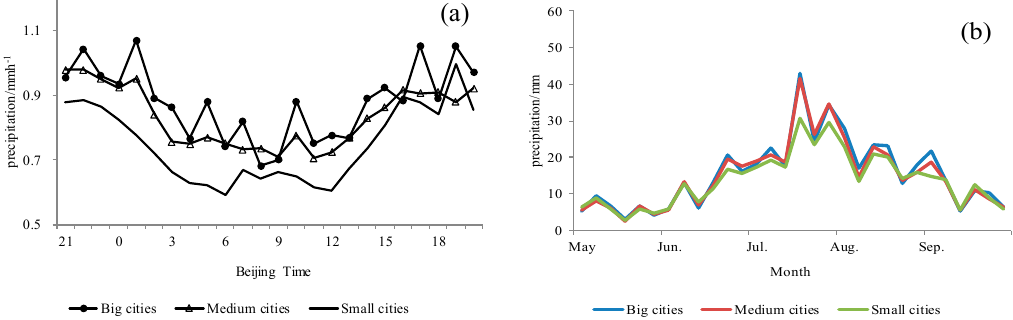
Figure 12. The diurnal precipitation variations (hourly mean precipitation) ( a ) and intra-seasonal variations (pentad mean precipitation); ( b ) for di ff erent categories of cities, 2007–2017. Overall, the annual total precipitation during the 11 years is 49.8 mm or 12% higher at the large city stations than that at the small city stations, and 33.8 mm or 8% higher at the medium-sized city stations than that at the small city stations (Table 1). The city stations are located at approximately similar elevations, with the large city station slightly lower than the medium-sized city stations, and 300 m lower than the small city stations (Table 1). Therefore, the possible e ff ect of altitude on the precipitation di ff erence between large city and medium-sized city stations can be ruled out due to having almost the same altitudes, but the precipitation di ff erences of small city stations from those of large city and medium-sized city stations would be, to some extent, a ff ected by the altitude di ff erence. Figure 13 shows the relationship between warm-season precipitation of all the non-city stations and their altitudes. A weak but significant negative correlation is notable and unexpected, and the decreasing rate of precipitation with altitude in the whole river basin is − 7.9 mm / 100 m. This relationship between precipitation and altitude could be regarded as the background lapse of rainfall in the basin. Considering this influence of altitude, however, the warm-season precipitation at large city stations (459.9 − 24.4 = 435.5 mm) is still obviously higher (6.2%) than that at the small city stations at the same altitude, and the precipitation at the medium-sized stations is marginally higher (2.5%) than that of the small city